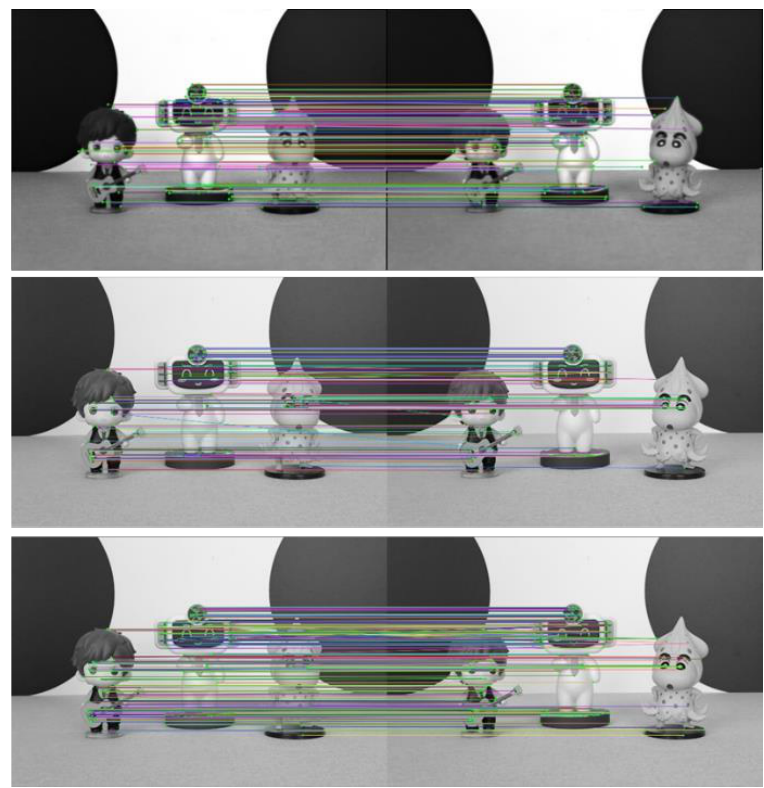
Figure 10. Scene 4 image feature point matching results. The final feature point matching pairs for the light field central subaperture images and light field full-focus images in the four scenes are shown in Table 2 below. Table 2. Number of matching pairs of image feature points.